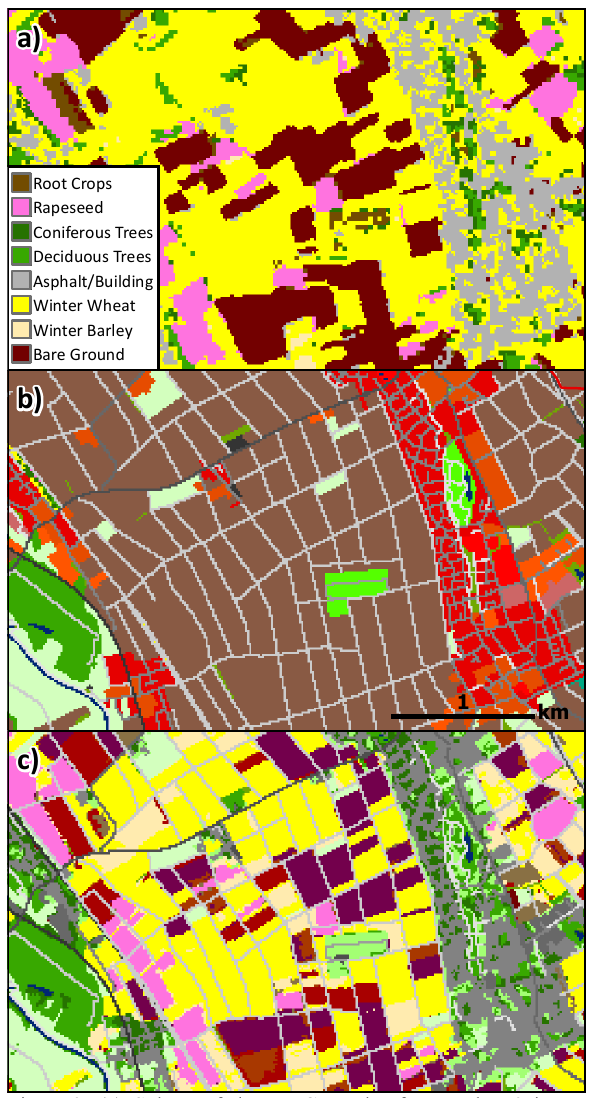
Figure 2. (a) Subset of the MLC result of a Landsat-8 image (05.05.2014). (b) Selected ATKIS classes (rasterised). Dark red to orange tones indicate different residential and commercial land uses, dark to light green colours denote forest, non- agricultural vegetation and grassland whereas grey colours differentiate road categories. (c) MDA classification of 2014 (Lussem and Waldhoff,